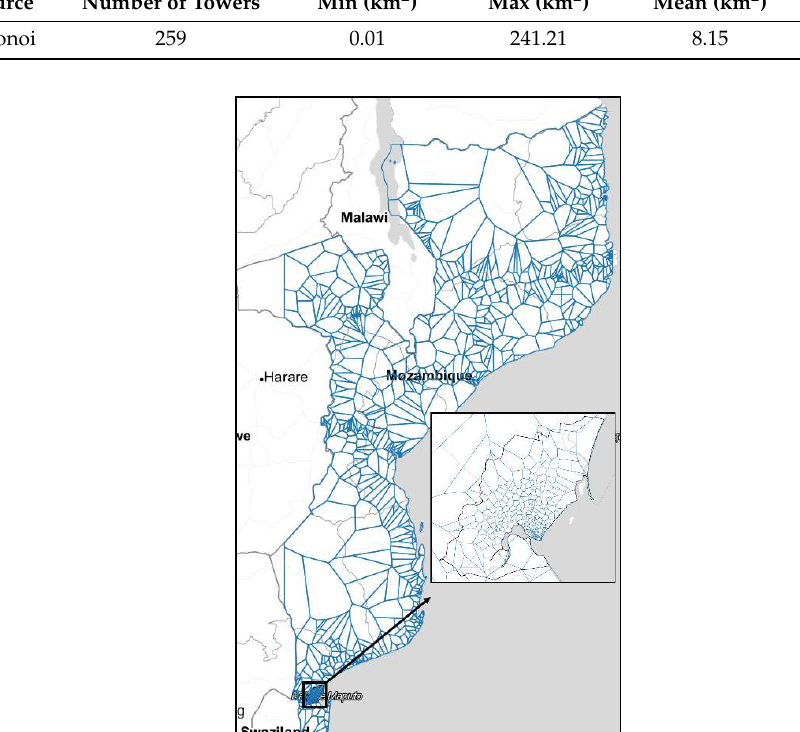
Figure 6. Voronoi diagram of the study area (magnified area), representing the mobile network coverage of each cellular tower.